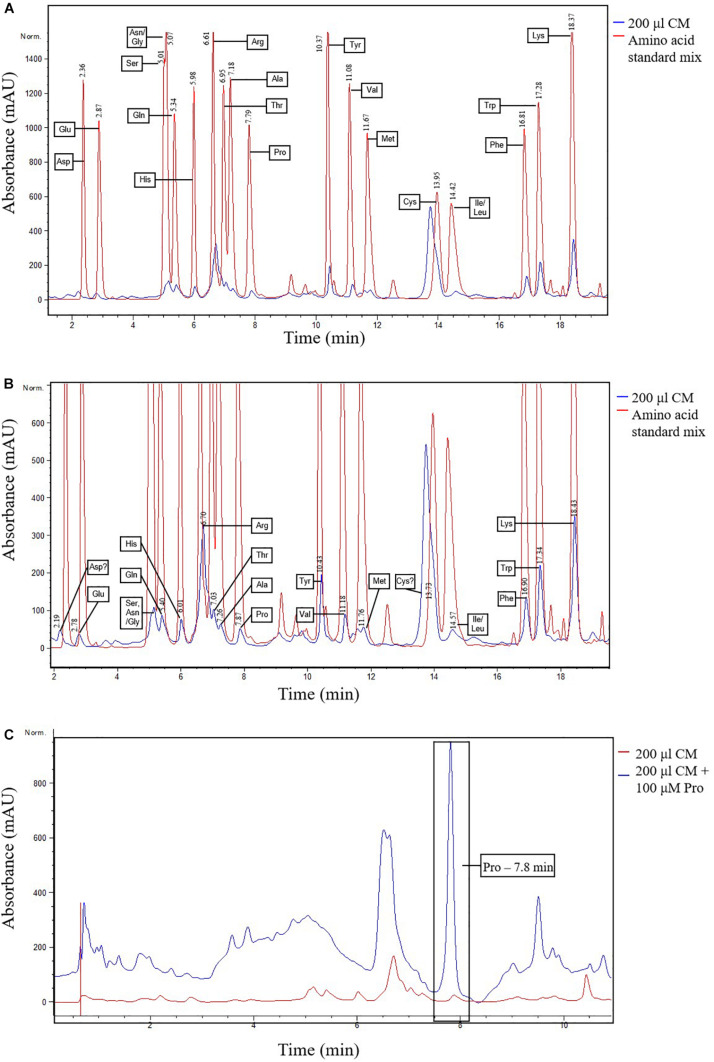
Detection of proline and other amino acids in N. muscorum CM sample. (A) Overlaid chromatogram of N. muscorum CM and amino acid standard mix and (B) its close-up view of the individual amino acid peaks. (C) Confirmation of the elution of proline at the 7.8 min point by spiking N. muscorum CM with an internal 100 μM proline standard. Asp, Aspartic acid, Glu, Glutamic acid, Ser, Serine, Asn, Asparagine, Gly, Glycine, Gln, Glutamine, His, Histidine, Arg, Arginine, Thr, Threonine, Ala, Alanine, Pro, Proline, Tyr, Tyrosine, Val, Valine, Met, Methionine, Cys, Cysteine, Ile, Isoleucine, Leu, Leucine, Phe, Phenylalanine, Trp, Tryptophan, and Lys, Lysine.